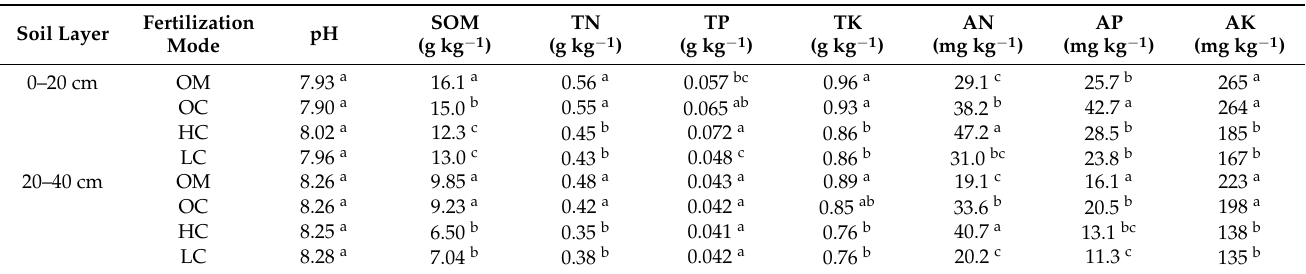
Table 2. Soil main properties in different fertilization